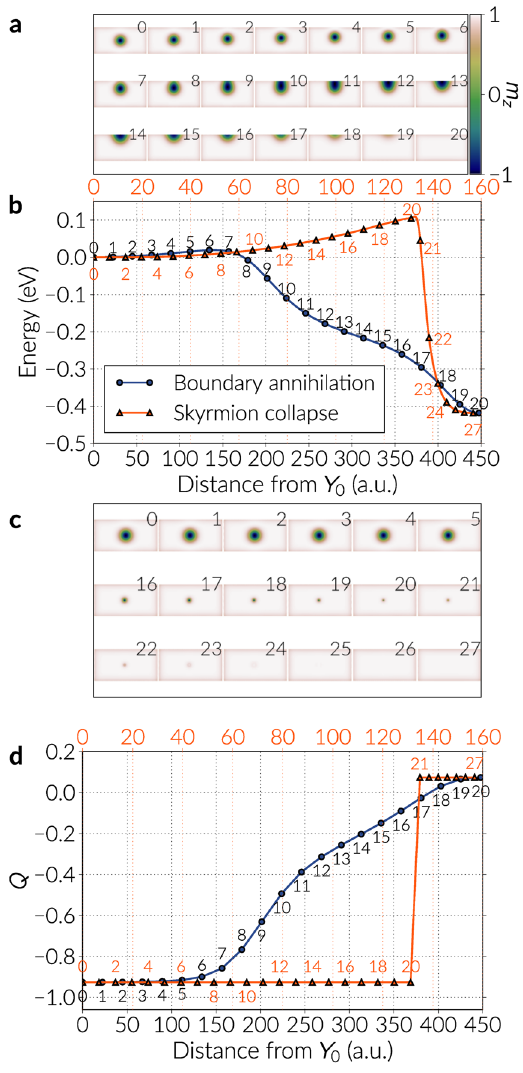
Figure 3. Minimum energy paths of a skyrmion in a cobalt nanotrack. The DMI constant of the system is D = 0.676 meV of magnitude. There are two different paths: a skyrmion annihilation at a boundary and a symmetrical skyrmion collapse. ( a ) Images of the band for the boundary annihilation, annotated according to the numbers in the corresponding curve in ( b ). The colour scale refers to the out of plane ( z ) component of the magnetisation field. ( b ) Energy bands for both minimum energy paths as a function of the distance from the first image (left extreme of the bands). The top scale refers to the skyrmion collapse case. ( c ) Images of the band for the skyrmion collapse. ( d ) Topological charge (skyrmion number) Q as a function of the images distances for the cases depicted in (b). The top scale refers to the skyrmion collapse